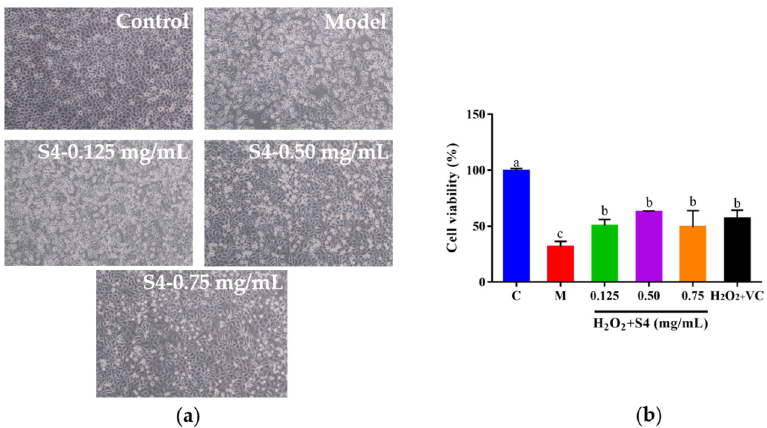
Figure 5. Effects of S4 at different concentrations on ( a ) cell morphology and ( b ) cell viability of H 2 O 2 -treated HepG2 cells. “C” represents the control group, and “M” represents the model group. Data were expressed as mean ± SD ( n ≥ 3, p < 0.05). Different letters indicate significant differences ( p < 0.05).